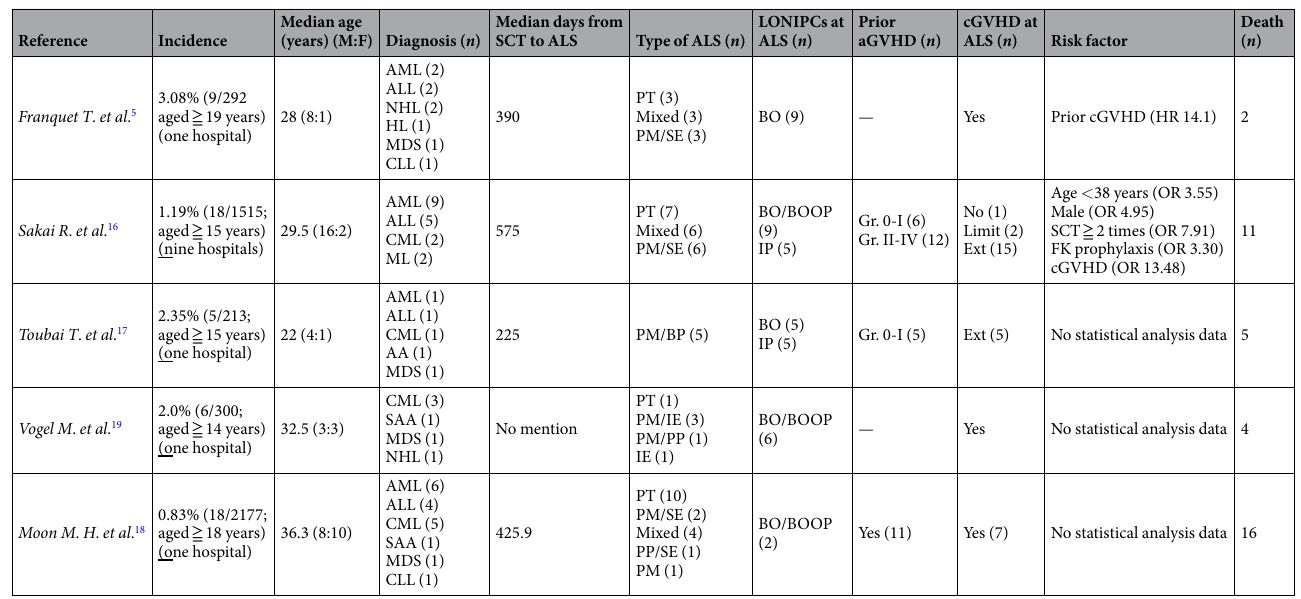
Table 4. Reported adult cases series of post-transplant thoracic ALS after 2000. ID, identification; M, male; F, female; SCT, stem cell transplantation; ALS, air-leak syndrome; aGVHD, acute graft-versus-host disease; cGVHD, chronic graft-versus-host disease; Gr., grade; BO, bronchiolitis obliterans; BOOP, bronchiolitis obliterans with organizing pneumonia; IP, interstitial pneumonia; HR, hazard ratio; OR, odds ratio; Ext, extensive type; Limit, limited type; PM, pneumomediastinum; MOF, multiple organ failure; PT, pneumothorax; BP, pneumothoraces; IE, interstitial emphysema; PP, pneumopericardium; SE, subcutaneous emphysema; Mixed, PT with ME/SE/IE; FK, tacrolimus; AML, acute myeloid leukemia; ALL, acute lymphoblastic leukemia; CML, chronic myeloid leukemia; CLL, chronic lymphocytic leukemia; MDS, myelodysplastic syndrome; SAA, severe aplastic anemia; AA, aplastic anemia; ML, malignant lymphoma; NHL, Non-Hodgkin lymphoma; HL, Hodgkin